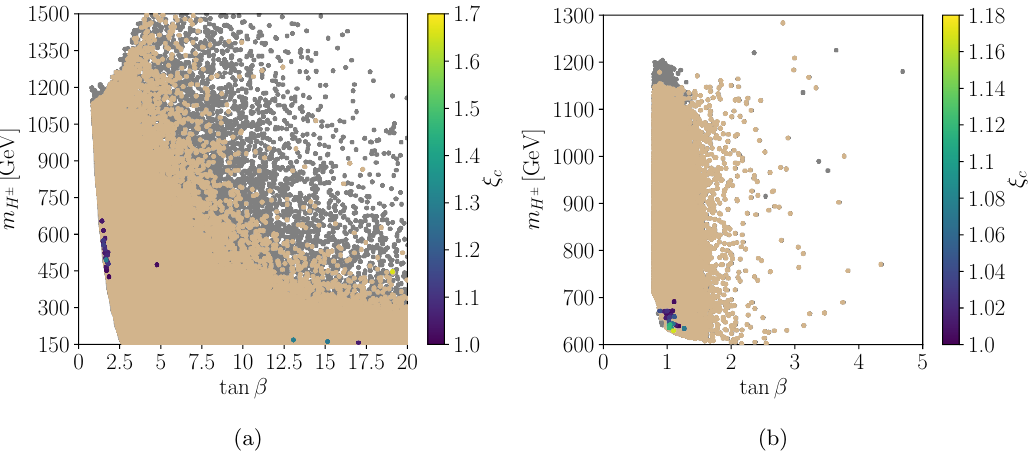
Figure 1 . C2HDM: the mass m versus tan (cid:12) for T1 (left) and T2 (right). The grey points are all H (cid:6) parameter points passing the experimental and theoretical checks of ScannerS . The brown points additionally ful(cid:12)ll NLO vacuum stability and NLO perturbative unitarity constraints. The color code denotes the strength of the phase transition (cid:24) c for (cid:24) c 1. The di-Higgs search constraints are (cid:21)